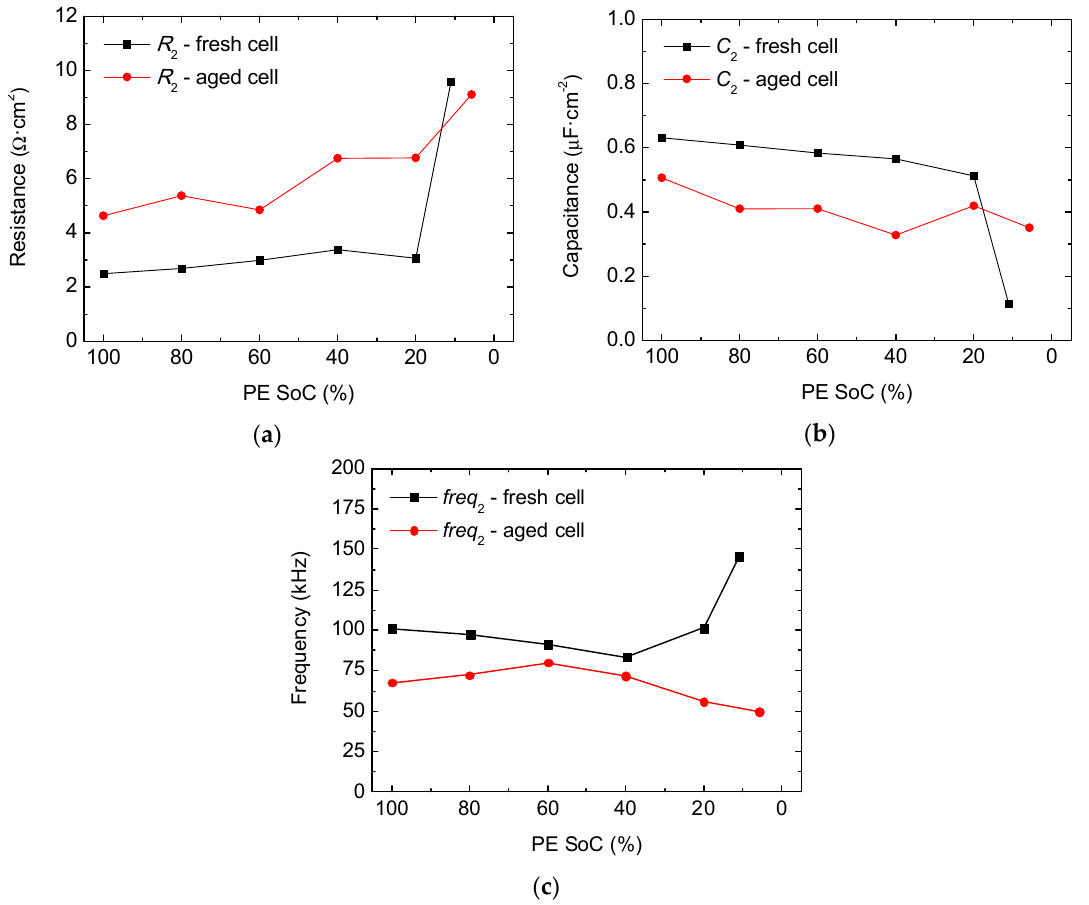
Figure 6. ( a ) Resistance, ( b ) capacitance, and ( c ) characteristic frequency related to P2_PE